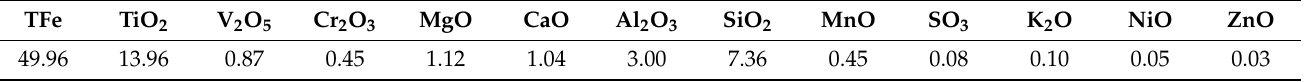
Table 1. Chemical composition of the vanadium–titanium magnetite used